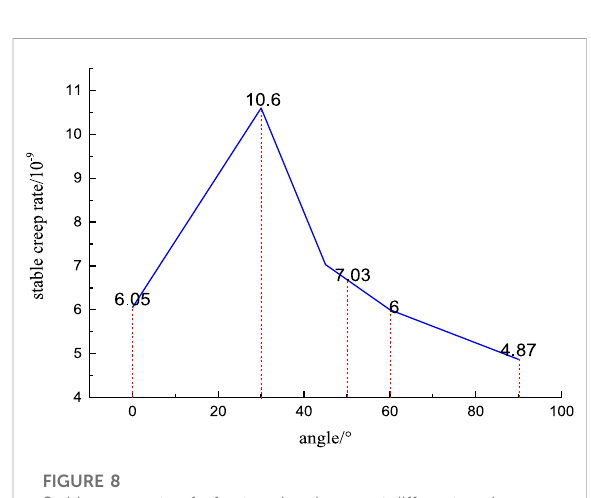
FIGURE 8 Stable creep rate of a fractured rock mass at different